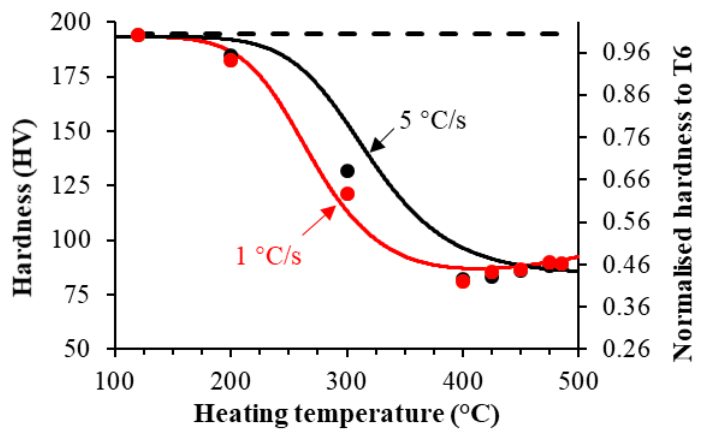
Figure 5. Effect of heating rate on hardness of AA7075-T6 heated to different temperatures, where the symbols represent the experimental determined hardness and the solid lines represent the model predictions.